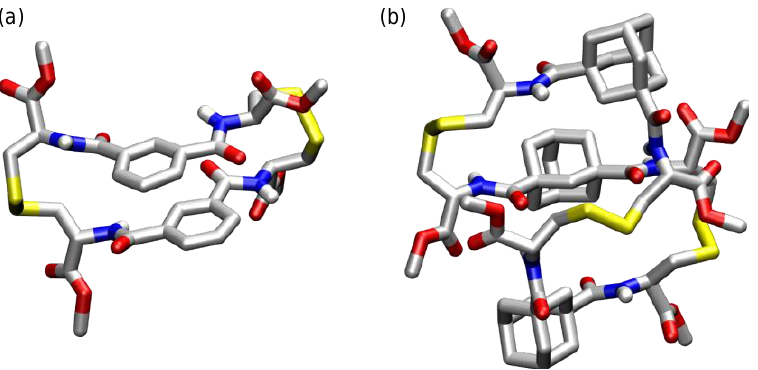
Figure 5. Crystal structures of 7a (CSD Entry: NOSQIV) ( a ) and 8 (CSD Entry: TUHRAP) ( b ). Solvent molecules and protons, except acidic ones, are omitted for reasons of clarity.